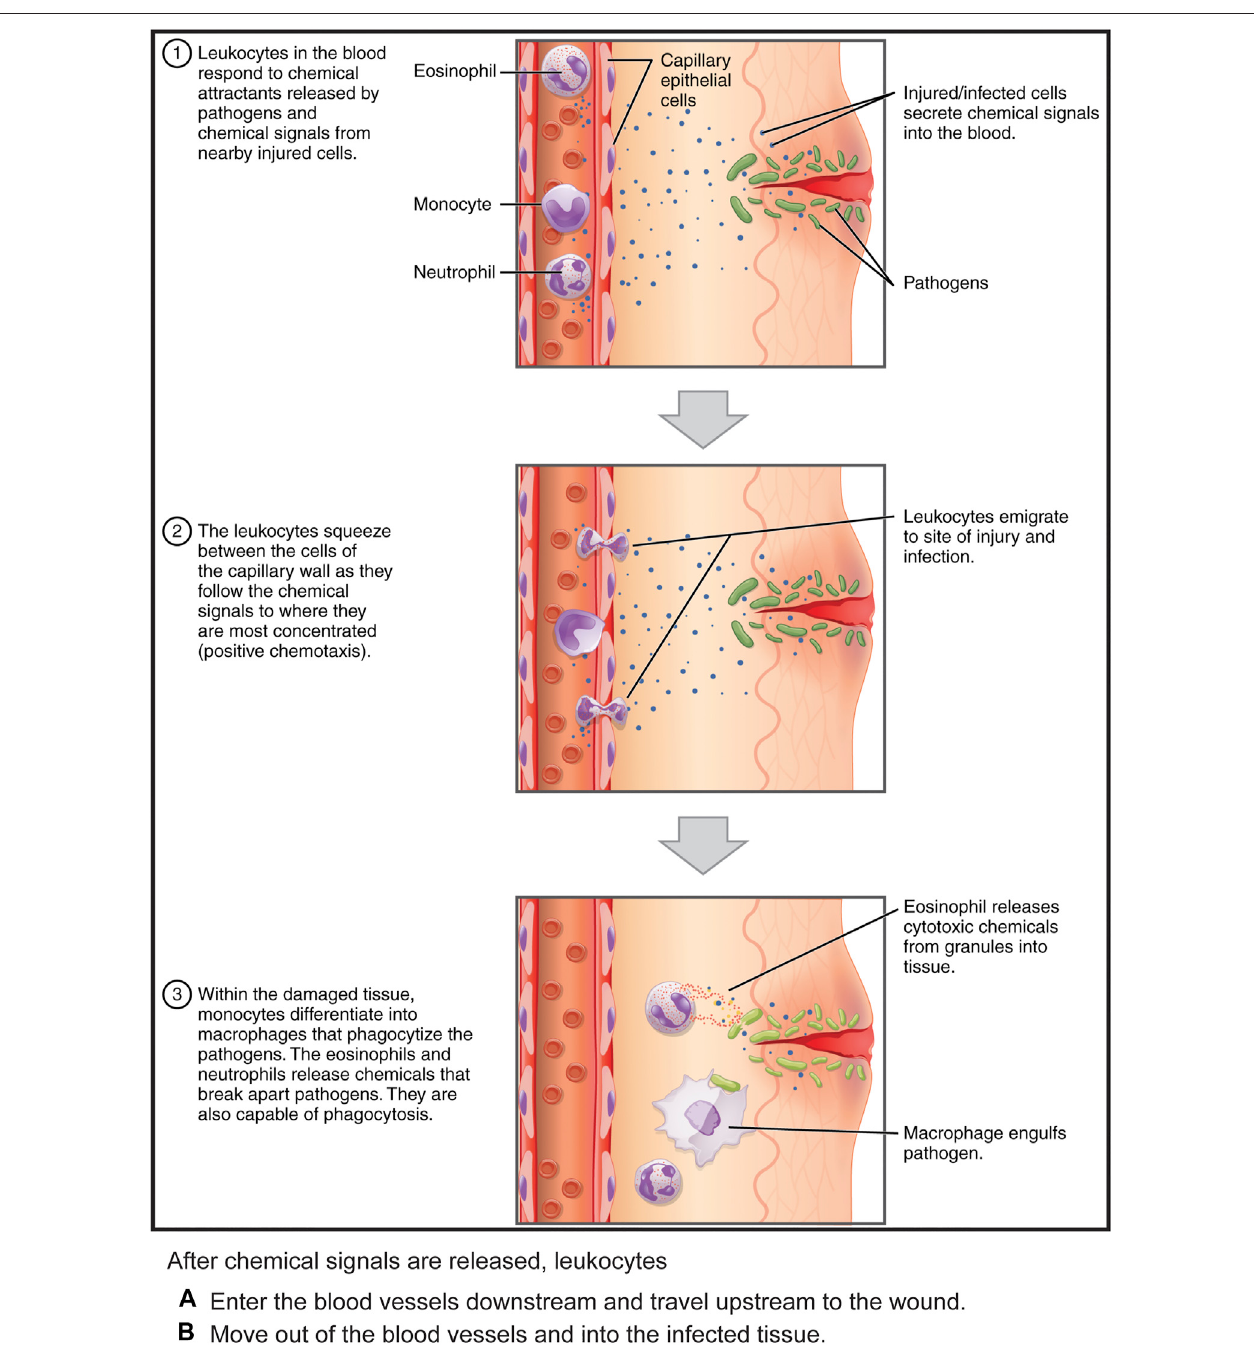
FIGURE 3 | Example IMRB test question 1